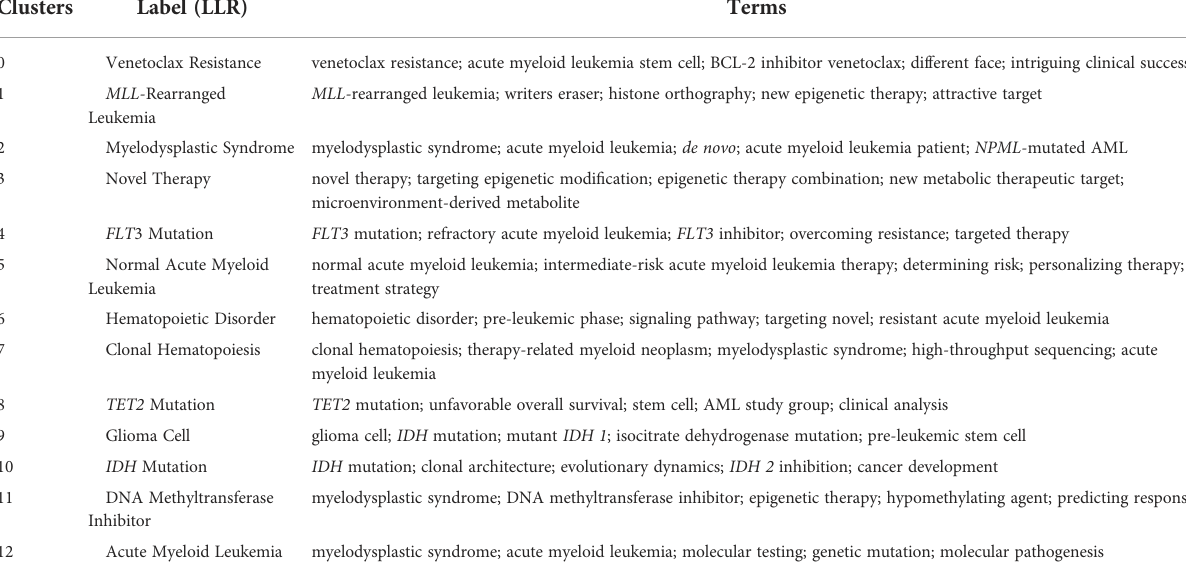
TABLE 3 The information of clusters about reference co-citation analysis.